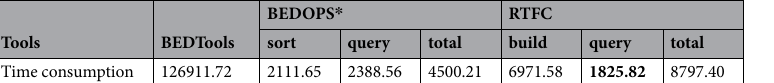
Table 8. The time consumptions (in seconds) of BEDTools and BEDOPS for coarse interval intersection query compared with RTFC. The data intervals are ENCODE intervals and query intervals are gnomAD intervals. * BEDOPS cannot return the detailed intersection information as RTFC and BEDTools, it returns only the subset of overlapping intervals in the first bed file and ignores the overlapping intervals in the second bed